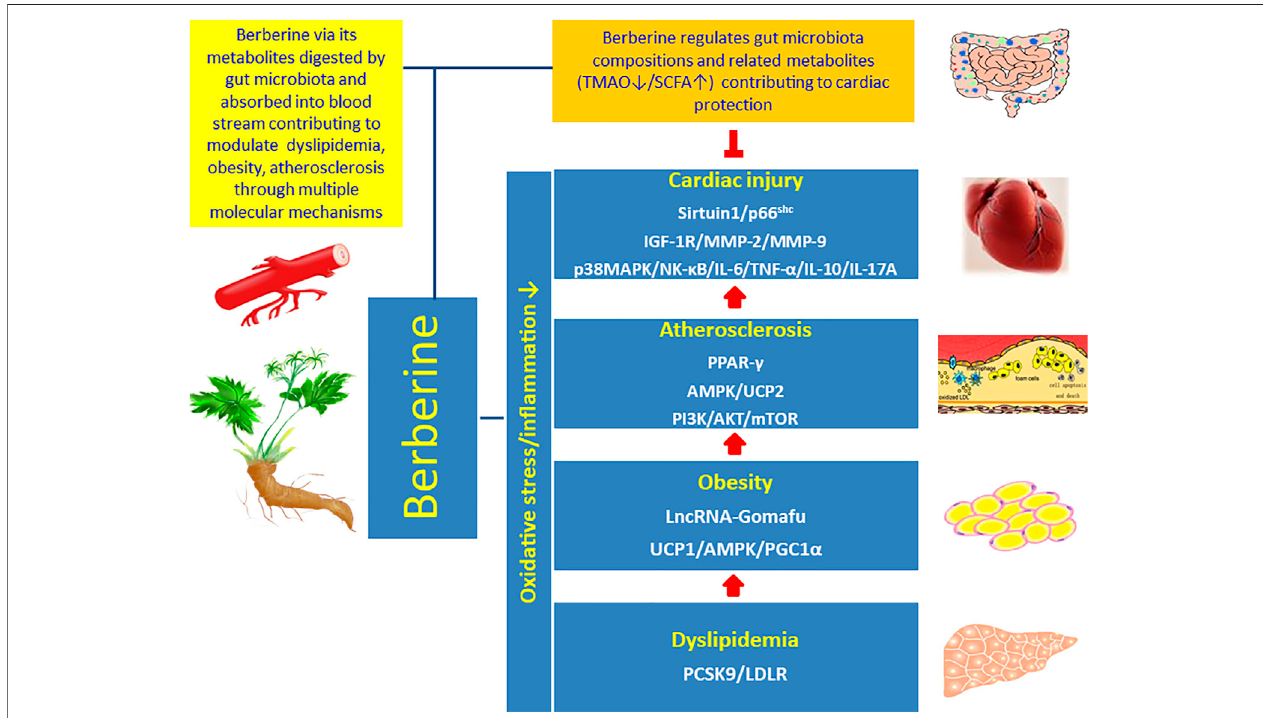
FIGURE3| Interactionofberberinewiththegut-heartaxis.Berberineinteractswiththegut-heartaxisthroughtwopathways:1)berberineregulatesgutmicrobiota compositions and related functional metabolites, for example inhibition of proatherogenic metabolite TMAO and promotion of antiatherogenic metabolite SCFA, which circulate tothedistalorgan heart and contribute toreducecoronary atherosclerosis;2) berberine viaits metabolites, digested byintestinal microbiota and absorbed into blood stream, contribute to modulate oxidative stress and in fl ammation related dyslipidemia, obesity, and atherosclerosis to inhibit cardiac injury via multiple molecular signaling